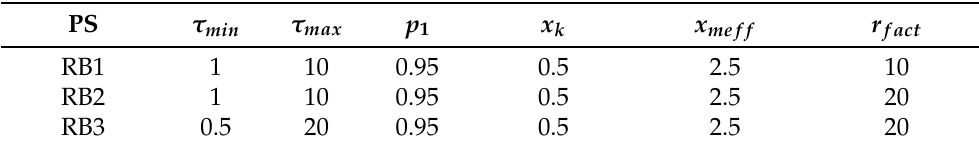
Table A1. Input parameters for the Reasenberg clustering algorithm. The first row corresponds to the standard parameter set